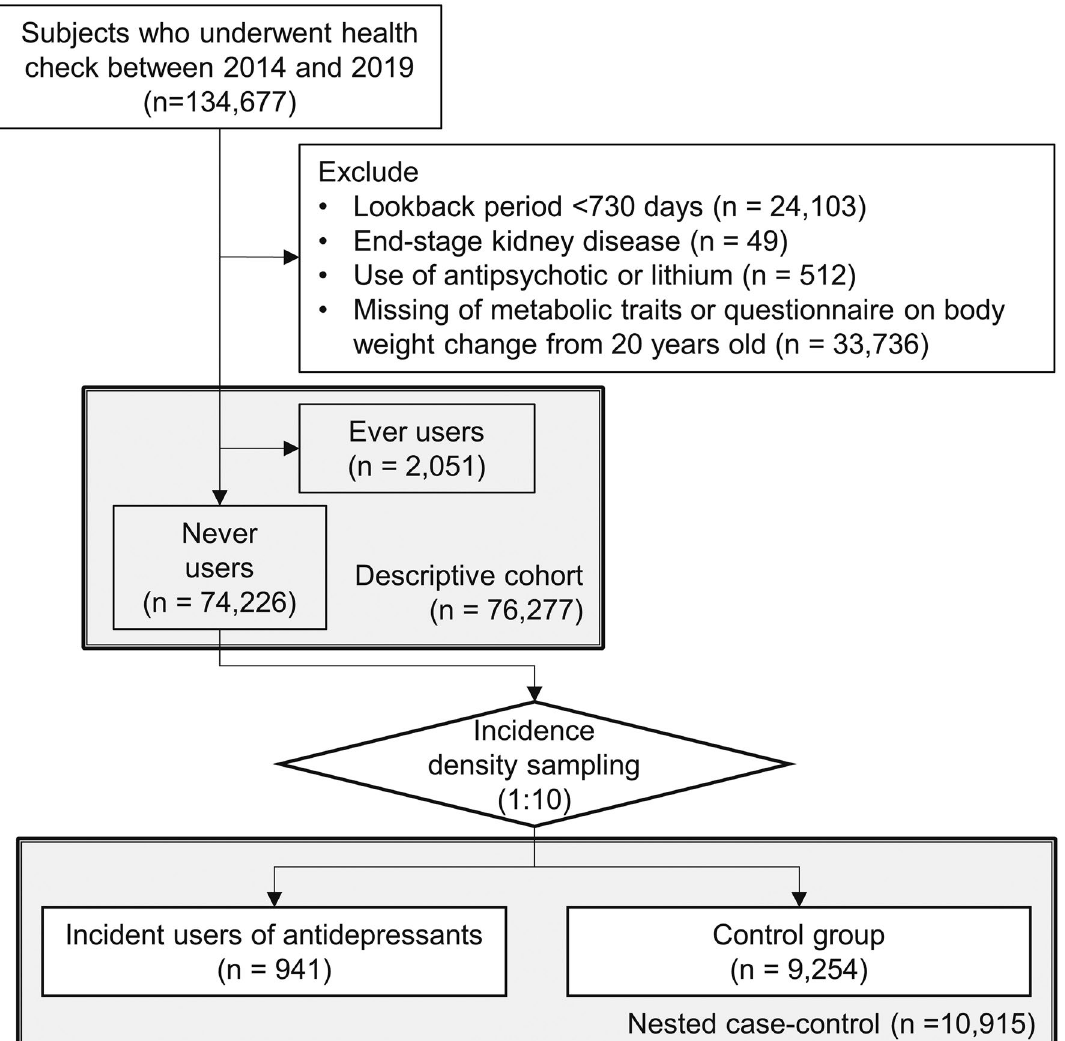
Figure 1. Flow diagram of study subject selection. Flow diagram of study subject selection. The descriptive cohort includes both ever and never users of antidepressants (N = 76,277). The nested case–control study was conducted at a 1:10 ratio of incidence density sampling from never users of antidepressants (N =